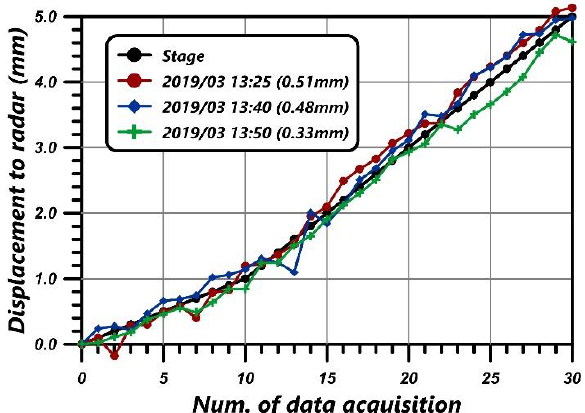
Figure 7. The verification test result of displacement measurement accuracy when the corner reflector was installed in the grass field